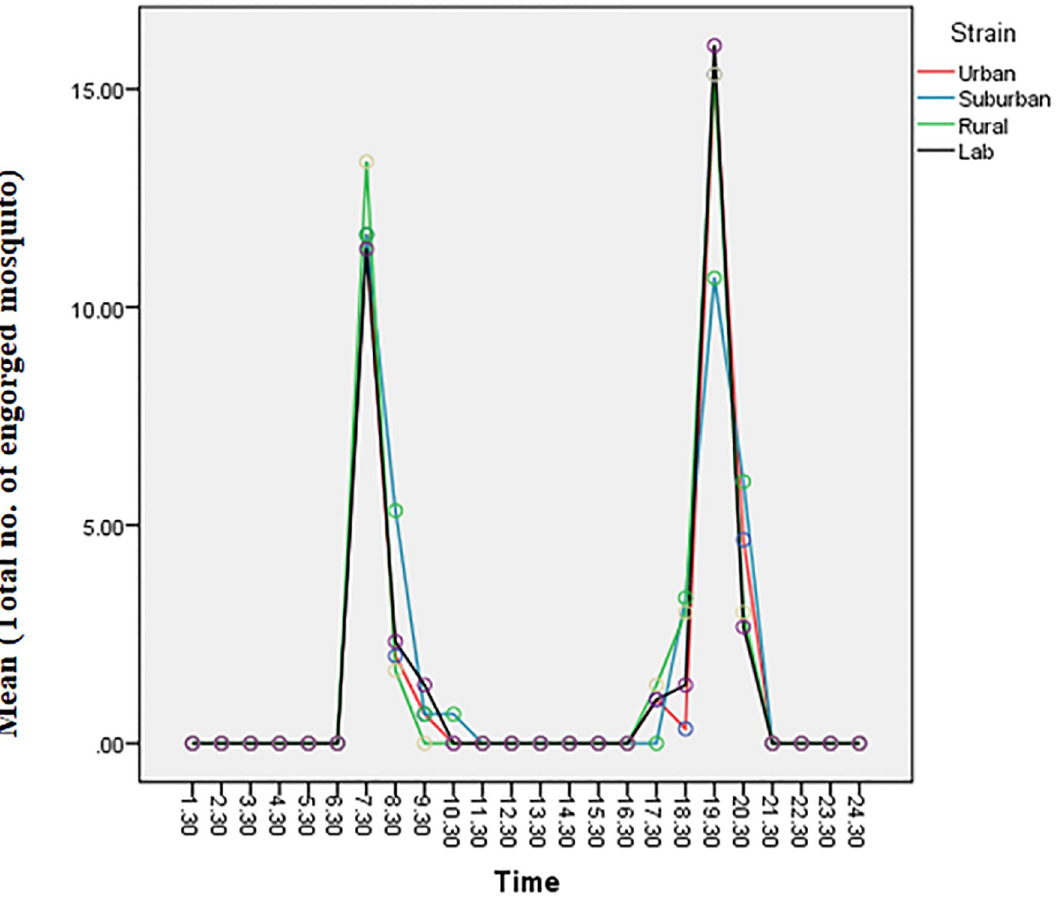
Fig 1. Biting rhythm of Aedes albopictus females from four strains; urban, suburban, rural, and laboratory.